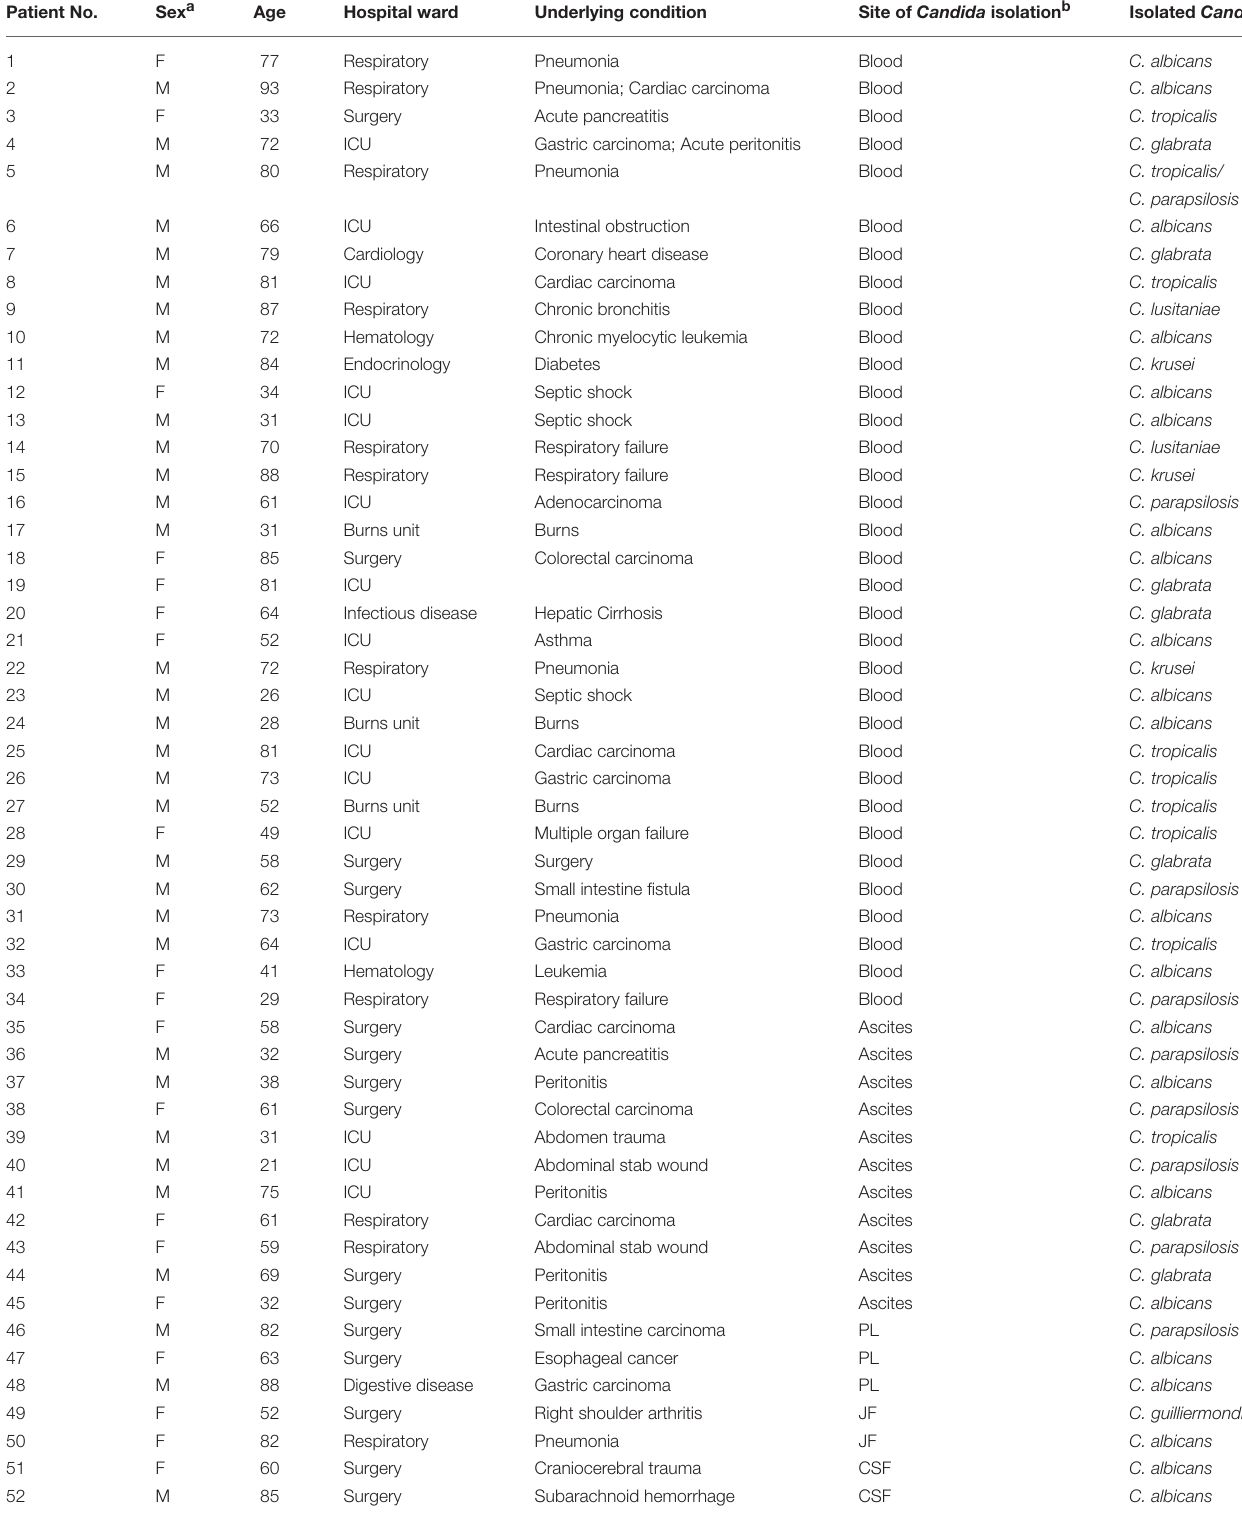
TABLE 1 | Base-line characteristics of the 52 patients with invasive candidiasis included in the study. Patient